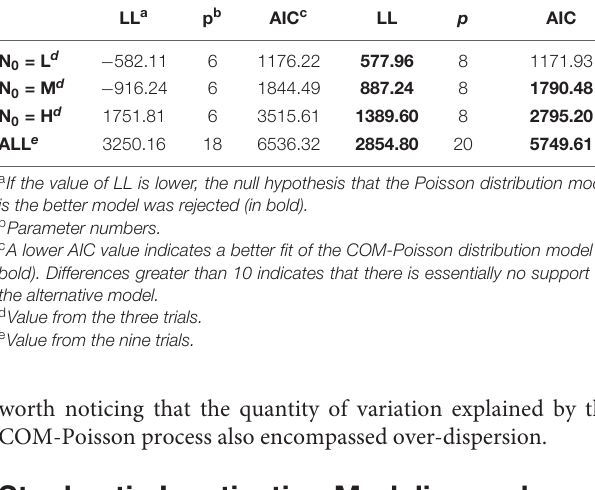
TABLE 7 | Observed and Monte Carlo simulation results for osmotic inactivation TABLE 6 | Log-likelihood value (LL) and Akaike information criterion (AIC) values to determine the better-fitted distribution between the Poisson and the COM-Poisson of L. monocytogenes starting with different initial cells (L: low inoculum, M: medium inoculum, H: high (eq. 13) processes for L. monocytogenes observed survivors starting with different initial cells (L, low inoculum; M, medium inoculum; H, high inoculum). Poisson COM-Poisson (Eq. 13)